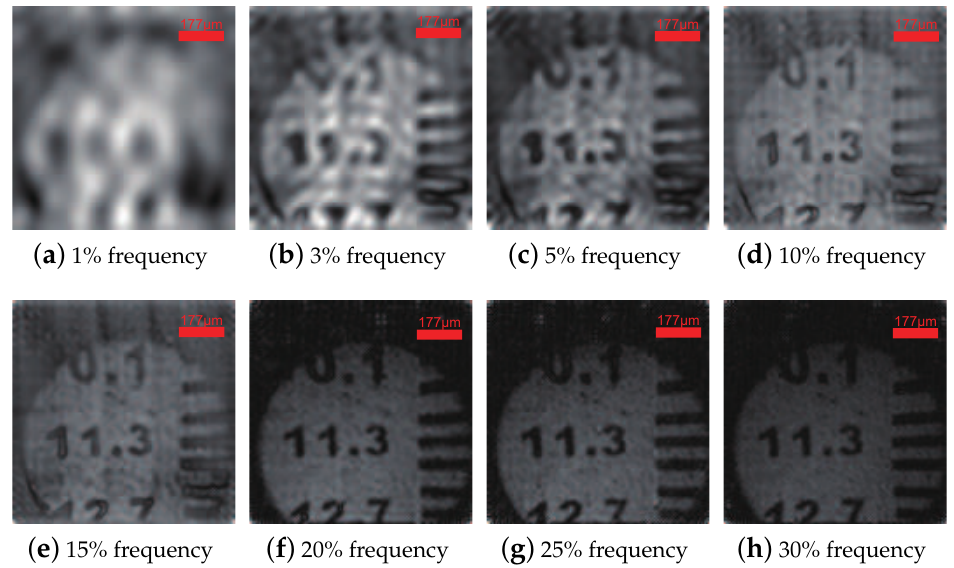
Figure 3. ( a – h ) Microimaging of different Fourier spectral sampling rates for USAF-1951 test target. The number 11.3 represents 11.3 LP/mm. Objective lens is 20